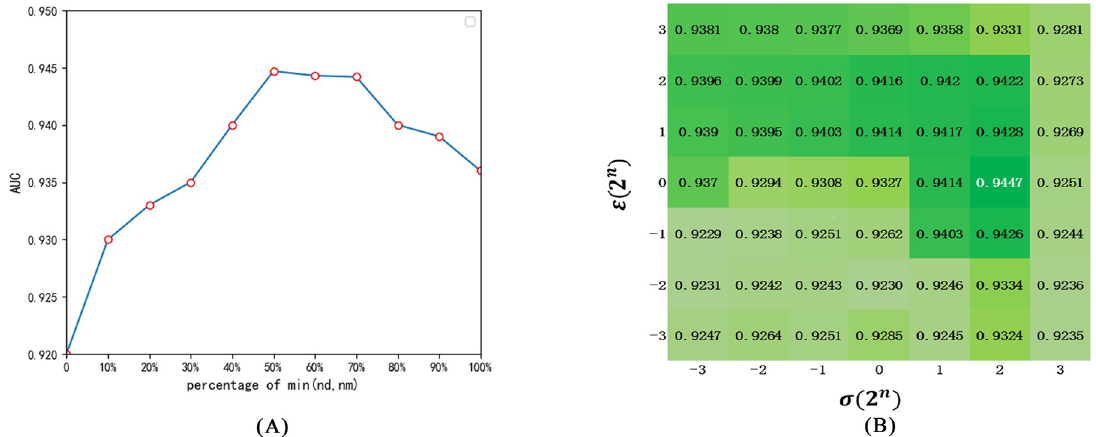
Fig 3. The influence of parameters on SCMFMDA: (A) the influence of γ ; (B) the influence of σ and ε .